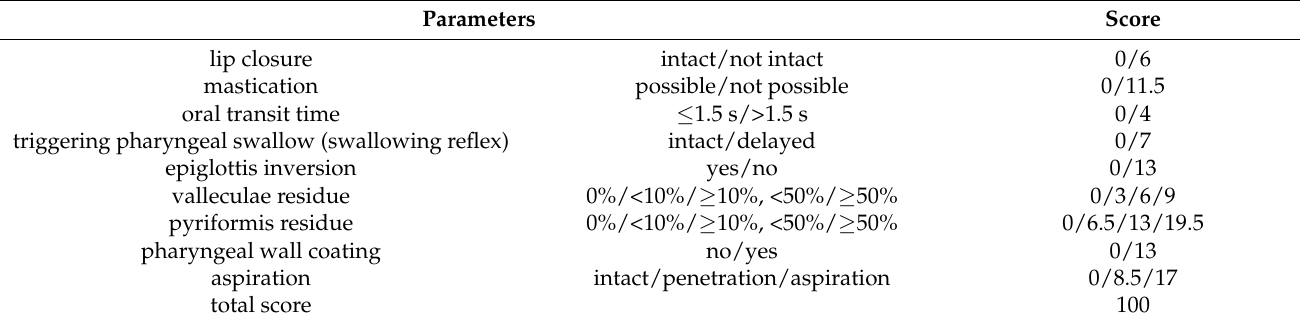
Table 2. Modified Videofluoroscopic dysphagia scale